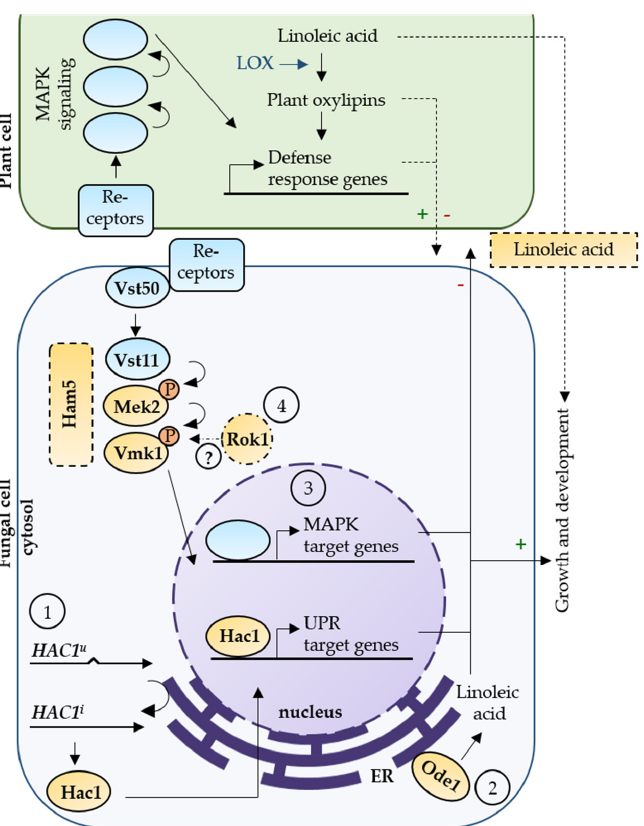
Figure 9. Model of Verticillium dahliae signaling pathways and of their functions in development and induction of disease symptoms. (1) The uninduced HAC1 mRNA ( HAC1 u ) is unconventionally spliced (arrow close to ER membrane), resulting in the basic leucine zipper transcription factor Hac1 encoding HAC1 i mRNA. The translated Hac1 protein regulates UPR target genes. V. dahliae Hac1 has an impact on the response to ER stress, conidiation, vegetative growth even under non-stress conditions, and is essential for resting structure formation (arrow/green plus to “Growth and development”). Virulence of V. dahliae is strongly influenced by Hac1 (arrow/red minus from fungal cell), potentially by regulation of effector protein expression or secretion enabling circumvention of plant defense responses (arrow with dashed line/green plus from plant cell). (2) The V. dahliae oleate ∆ 12-fatty acid desaturase Ode1, catalyzing the linoleic acid biosynthesis, has a positive effect on vegetative growth (arrow/green plus to “Growth and development”) but only minor impact on disease symptom induction in the host. Linoleic acid provided by the plant might support fungal growth and differentiation (arrow with dashed line/green plus from plant cell). (3) V. dahliae MAPK signaling components Mek2 (MAP2K) and Vmk1 (MAPK) display positive impacts on vegetative growth and the formation of microsclerotia (arrow/green plus to “Growth and development”) and are essential for disease symptom induction in the host (arrow/red minus from fungal cell) independently from the V. dahliae Ham5 scaffold homolog. (4) The dual-specificity MAPK phosphatase Rok1 targets the counterpart of the MAPK Vmk1 in U. maydis [58], but the exact molecular function in V. dahliae is yet elusive (dashed arrow).